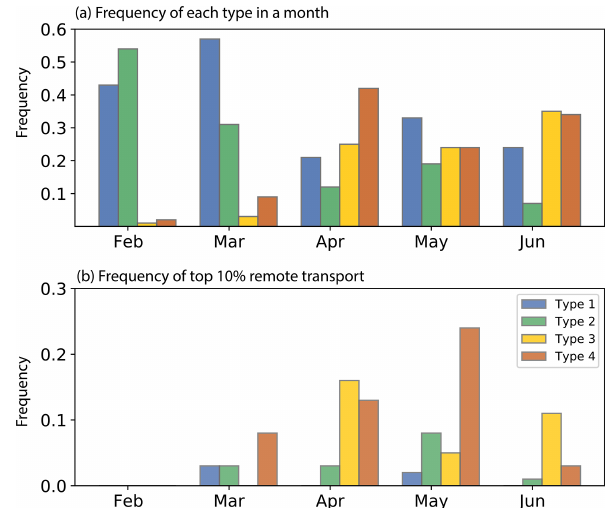
Figure 4. (a) The frequency of each type (the time dominated by each type divided by total time in a month) that occurs in February, March, April, May, and June in WRF-Chem. (b) The frequency of each type in the top 10% remote transport (the time dominated by each type divided by total time of the top 10% remote